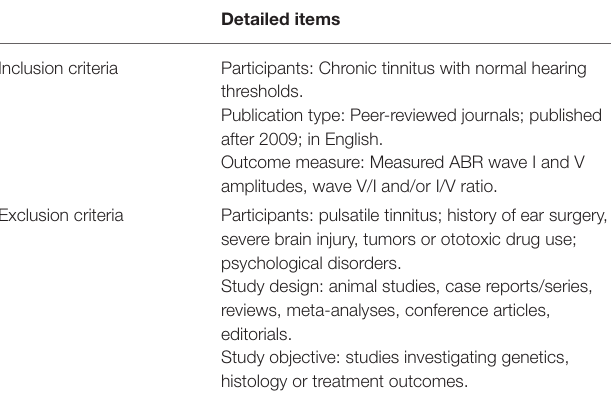
TABLE 1 | Inclusion and exclusion criteria for